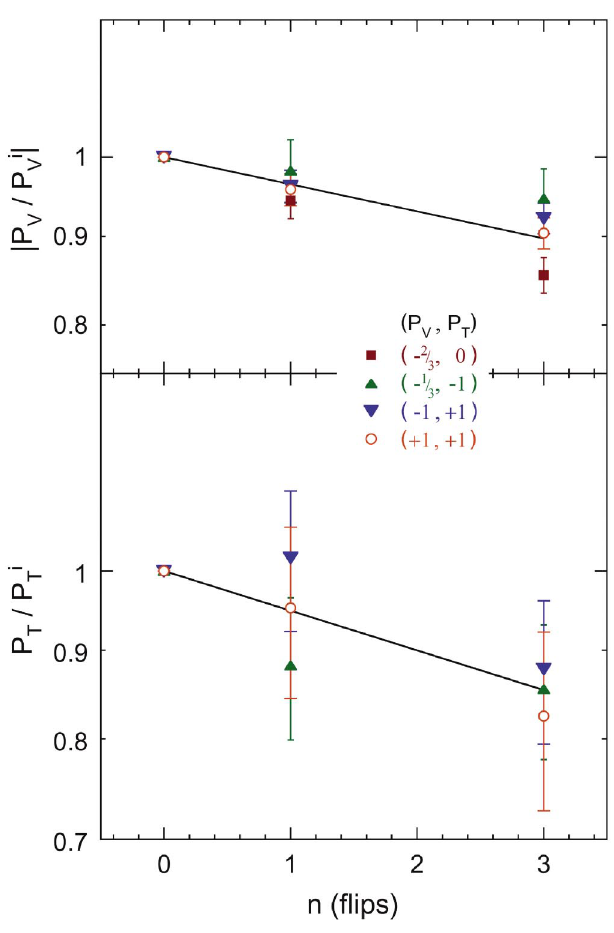
FIG. 8. (Color) The measured vector and tensor deuteron polar- ization ratios at 1850 MeV =c are plotted against the number of frequency sweeps. The rf dipole’s frequency ramp time (cid:18) t was 60 s; its frequency half-range (cid:18) f= 2 was 75 Hz , and its R B was 0 : 54 T mm . The lines are fits using Eq. (16).